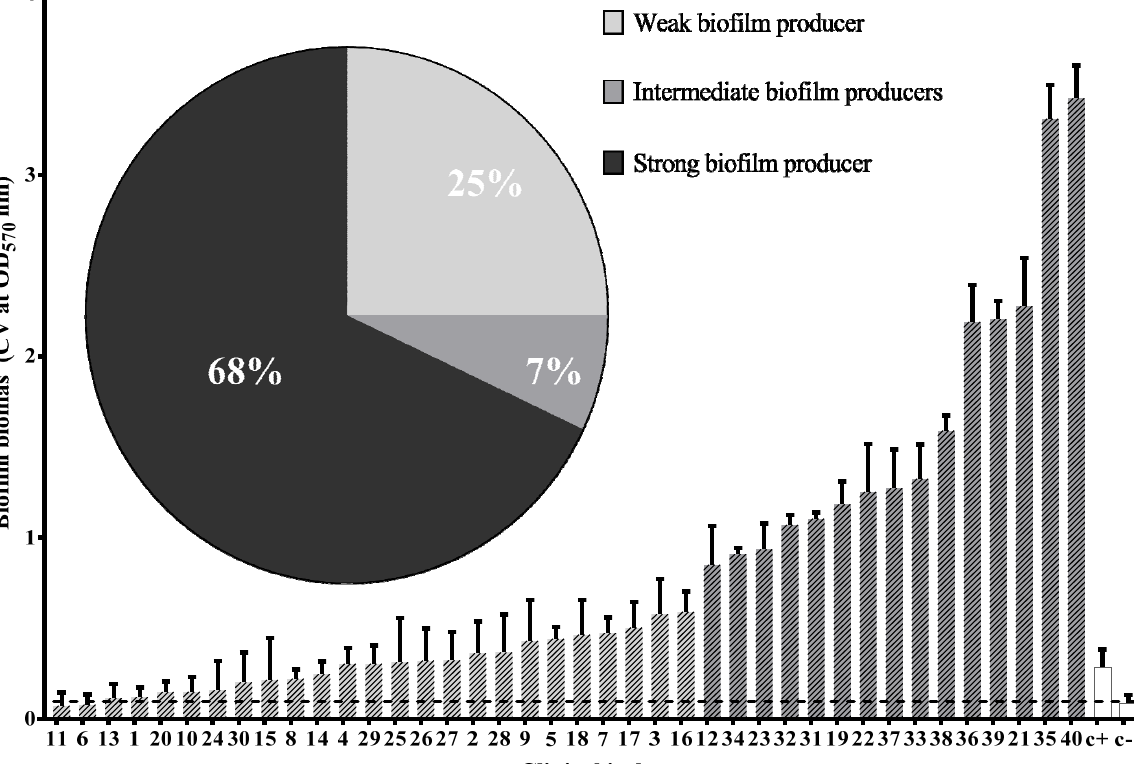
Figure 3. Biofilm production in clinical isolates of UPEC. The dotted line is at the level of the result obtained for the negative control. The biofilm biomass is expressed as the average OD at 570 nm of five independent experiments, error bars show standard deviation (SD). +C: Positive control ( Escherichia coli 25922); -C: Negative control (sterile Mueller-Hinton Broth.). Dark bars show the stronger biofilm producers with the most statistical significance ( p < 0.05) (Two-way ANOVA, Tukey’s multiple comparisons test), white bars show the implemented controls. Pie chart at the top shows the percentage of weak, intermediate, and strong biofilm forming UPEC clinical isolates.